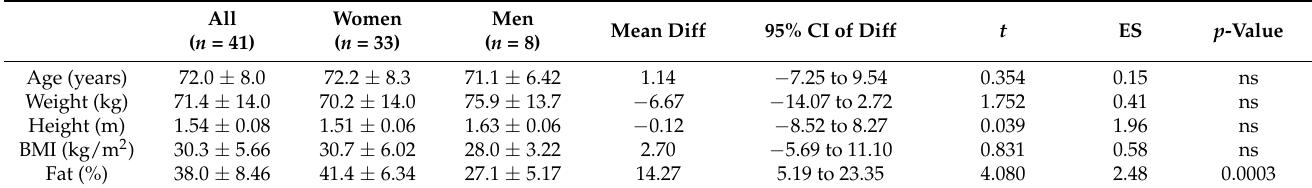
Table 1. Sample characterization